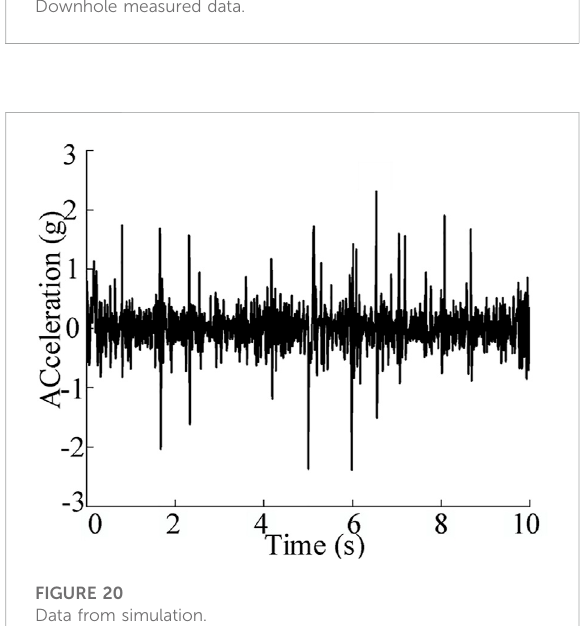
FIGURE 20 Data from